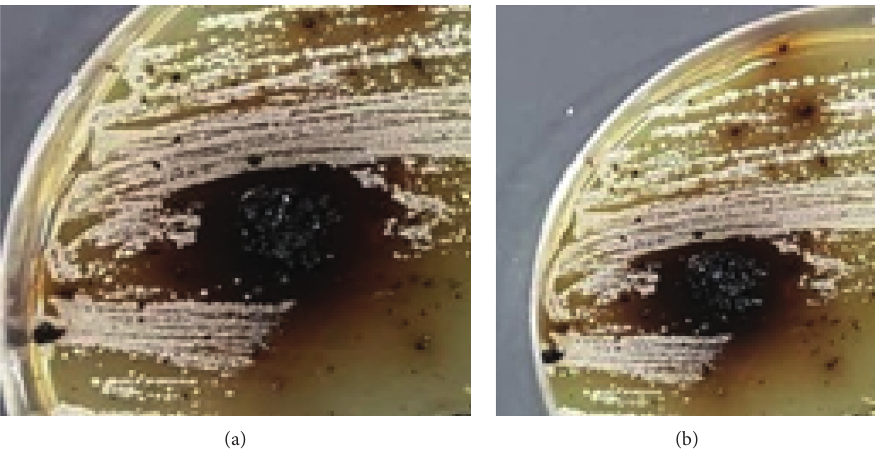
Figure 7: Inhibition areas for the synthesized nanoscale Cu (II) complex. (a) E. coli and (b) Staphylococcus aureus by agar-well diffusion method (concentration used: 100mM) in open condition. Table 4: Diameter of the halos in two types of testing